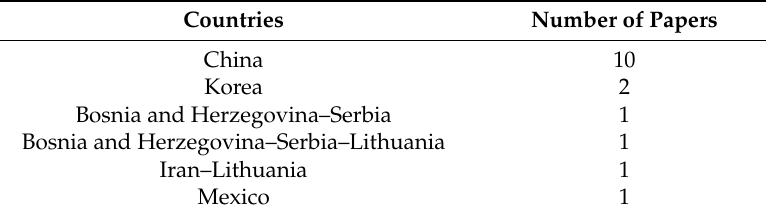
Table 1. Publications by country.